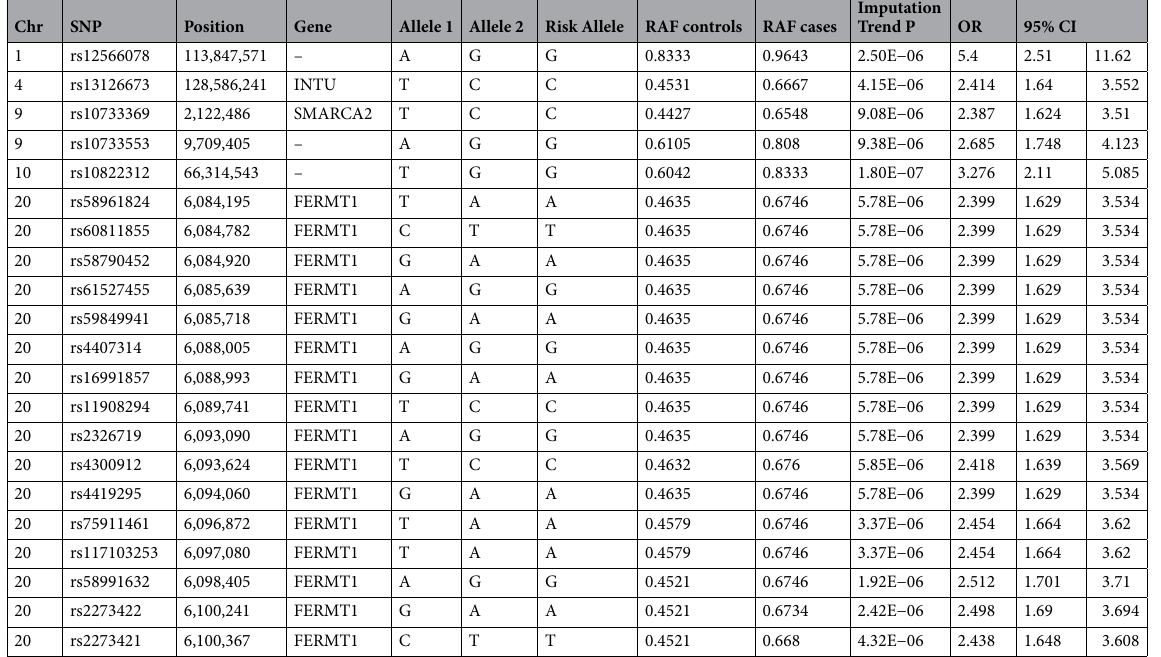
Table 4. Summary of imputation studies of top 21 SNPs in trend tests. RAF risk allele frequency, Trend P P vale of Trend test, OR odds ratio, CI confidence